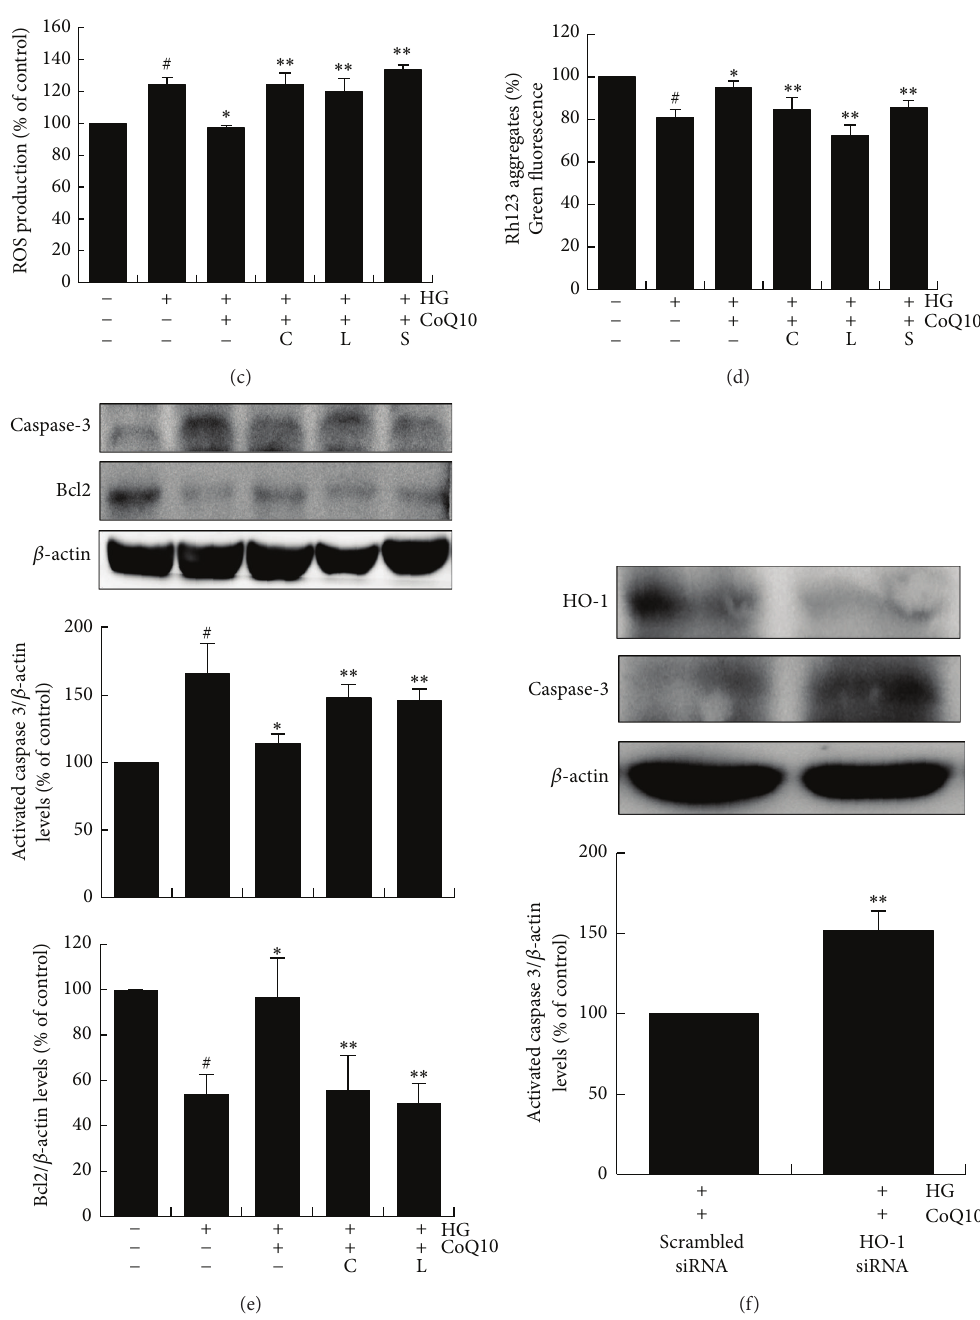
Figure 5: CoQ10 improves high glucose-induced EPCs dysfunction by upregulation of eNOS and HO-1. Cells were cultured with comp C (20 𝜇 M), L-NAMEA (100 𝜇 M), and SnPP IX (10 𝜇 M) for 60min before CoQ10 incubation under high glucose conditions. (a) EPC migration was measured by Boyden chamber assay. The migrated cells were stained with fluorescein isothiocyanate UEA-1 (lectin) (green) and counted under the fluorescence microscope. (b) Mitochondrial apoptosis was detected by JC-1. Loss of mitochondrial membrane potential ( ΔΨ m ) was assessed by the change in JC-1-derived fluorescence from red to green. The ratio of red/green fluorescence represented ΔΨ m in EPCs. (c) ROS production of EPCs was assessed by staining with DCFH-DA. (d) The mitochondrial function was measured using Rh123 dye (5 mM), and the fluorescence intensity was measured at 485-nm excitation and 530-nm emission using a fluorescent microplate reader. (e) Expressions of activated-caspase 3 and Bcl2 protein were assessed by western blot. (f) Cells were transfected with scramble and HO-1 siRNA (10nM), respectively,inCoQ10-treatedEPCsunderhighglucoseconditions,andtheexpressionsofactivated-caspase3andHO-1proteinweredetected by western blot. Comp C: component C, AMPK inhibitor; L-NAME, NO inhibitor; Snpp IX, HO-1 inhibitor. Data are mean ± SE; 𝑛 = 4 ; # 𝑃 < 0.05 versus control (5mM glucose); ∗ 𝑃 < 0.05 versus high glucose (HG); ∗∗ 𝑃 < 0.05 versus